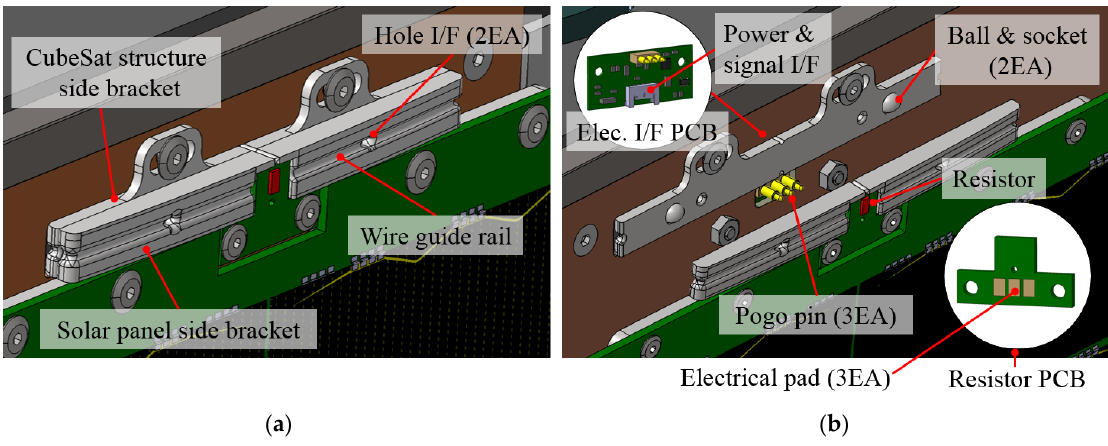
Figure 5. Configurations of three-pogo pin-based HRM: ( a ) solar panel fully stowed and ( b ) solar panel partially stowed. Table 5. Specifications of the hardware used in the three-pogo pin-based HRM.